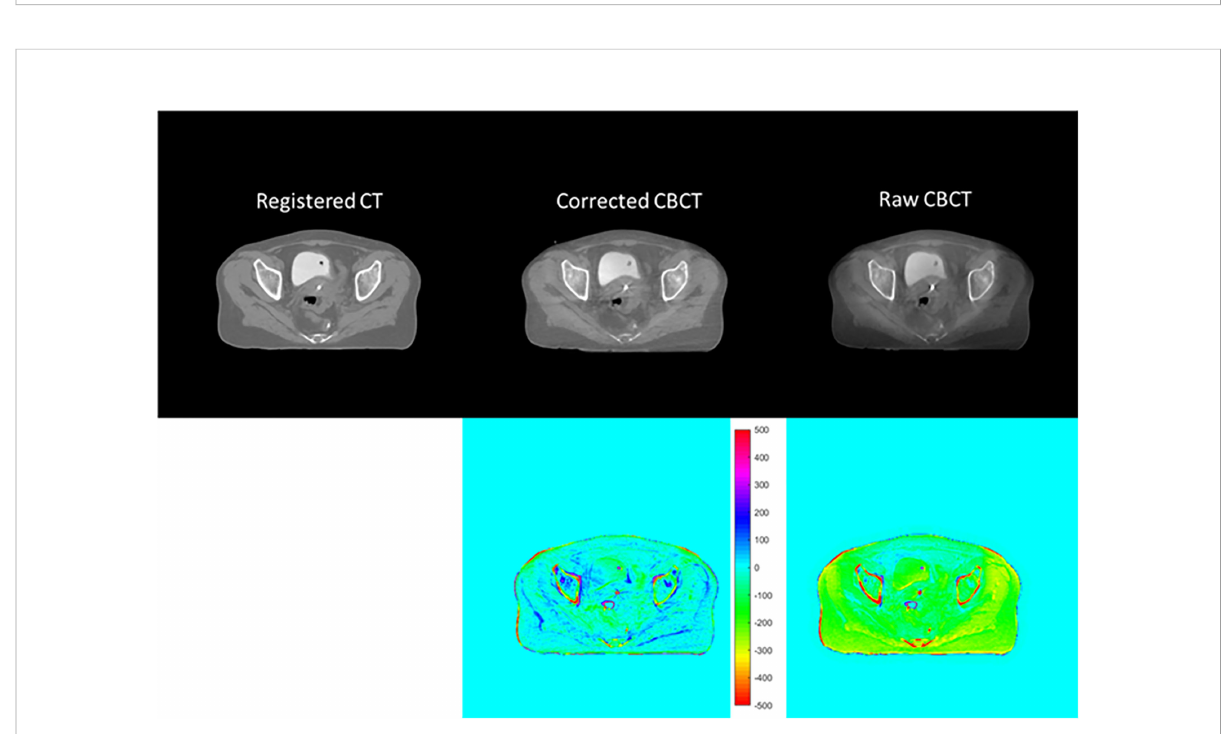
FIGURE 7 CT/CBCT images of the same patient in Figure 6 in the axial view and the CT number difference map of CBCT and CT; display window: [ − 500 500] HU.